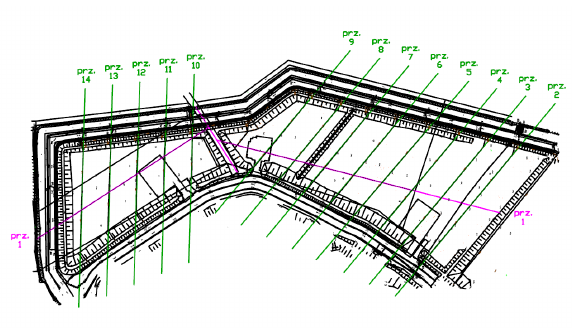
Figure 10: Horizontal projections of cross-section lines of solid waste landfill marked on an initial geodetic map (source: the au- thors’ own edition )